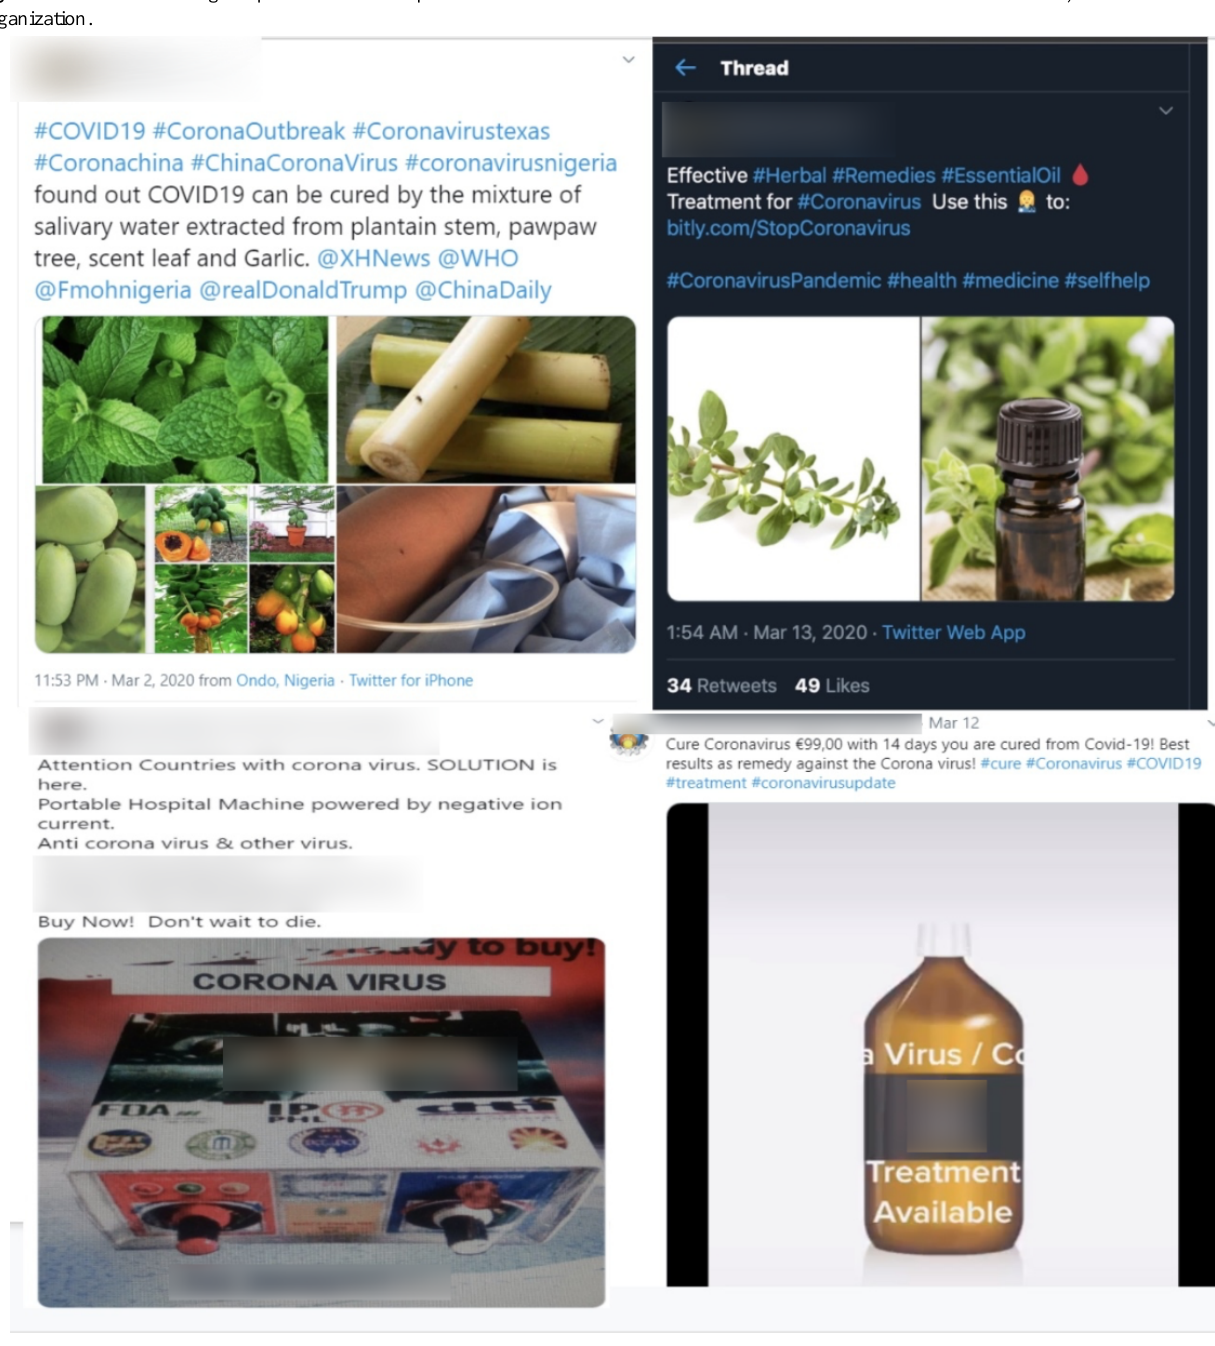
Figure 3. Twitter and Instagram posts related to suspected COVID-19 treatments and remedies. COVID-19: coronavirus disease; WHO: World Health